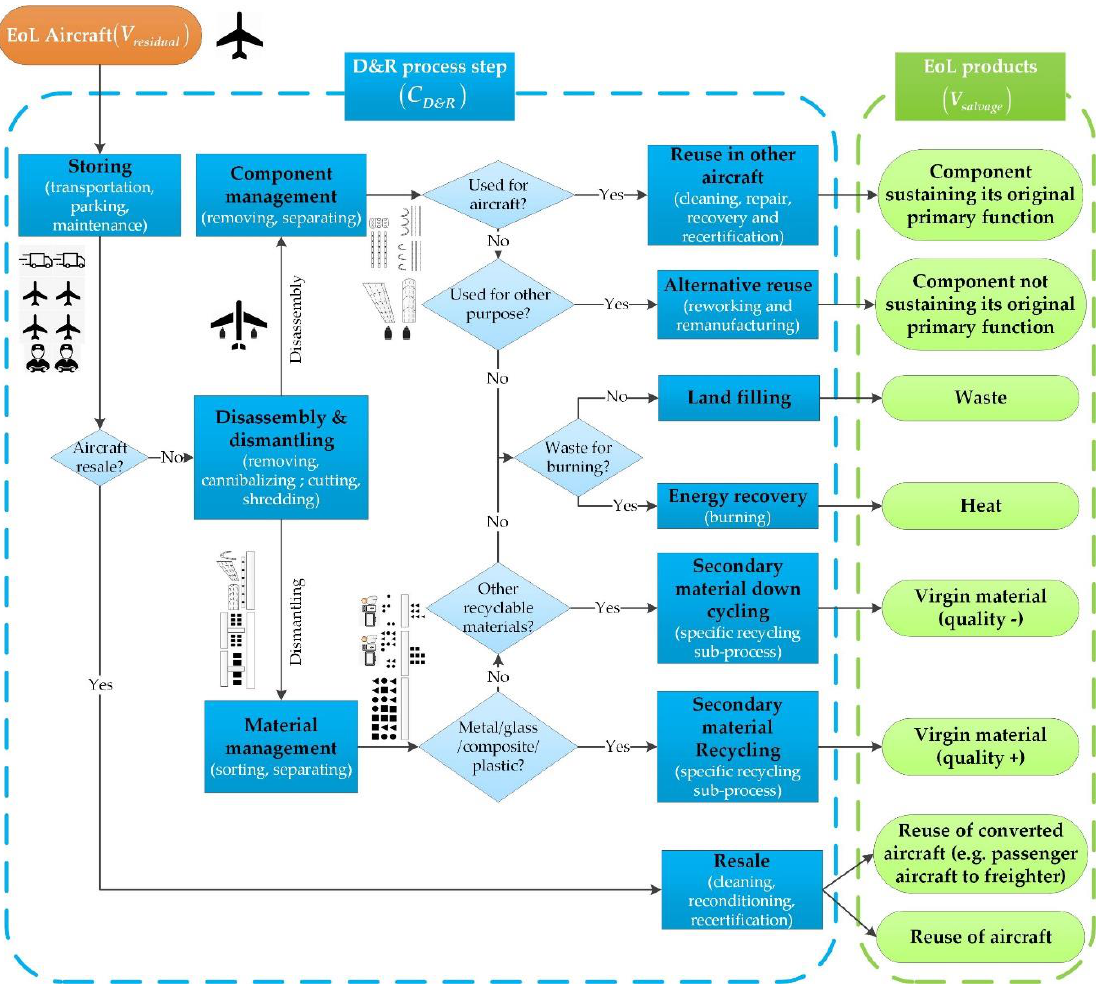
Figure 2. Aircraft disposal and recycle process model.